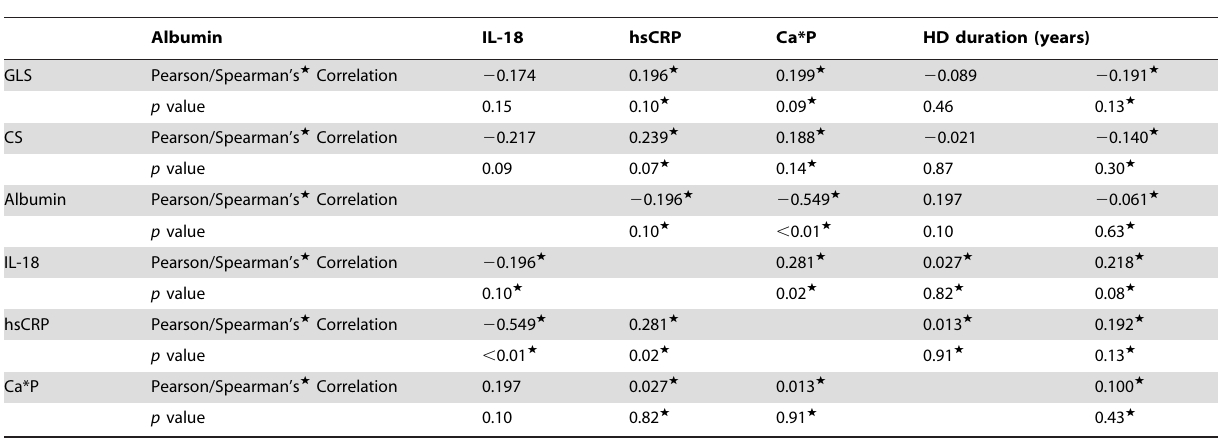
Table 5. Correlation study between different parameters.